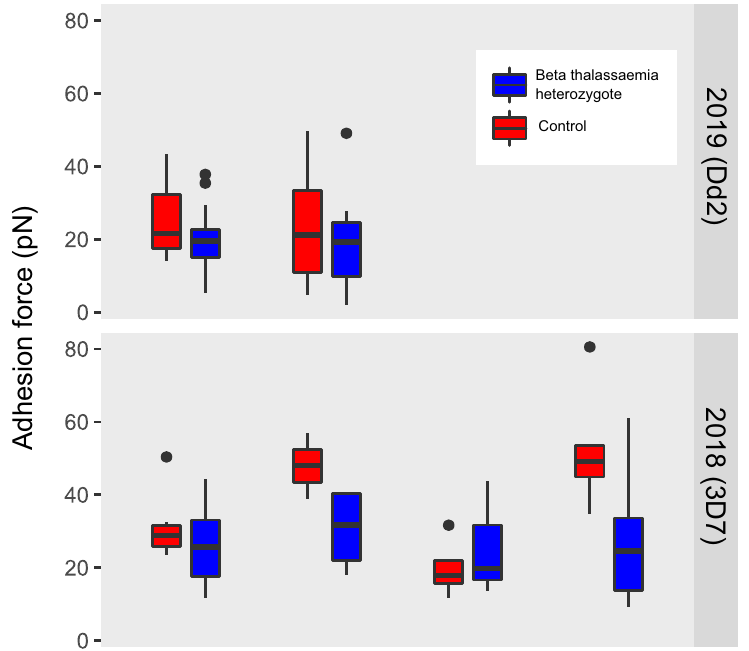
Figure 4. P. falciparum adhesion force for beta thalassaemic erythrocytes. The boxplots display merozoite adhesion force measured for 6 beta thalassaemic heterozygotes (blue boxplots) and 6 control non-beta thalassaemic samples (red boxplots). Samples subject to the same conditions (i.e. gathered on the same day) are grouped together. The number of cells measured to produce the results in each boxplot range between 3 and 15. Parasite strains used were 3D7 in 2018 and Dd2 in